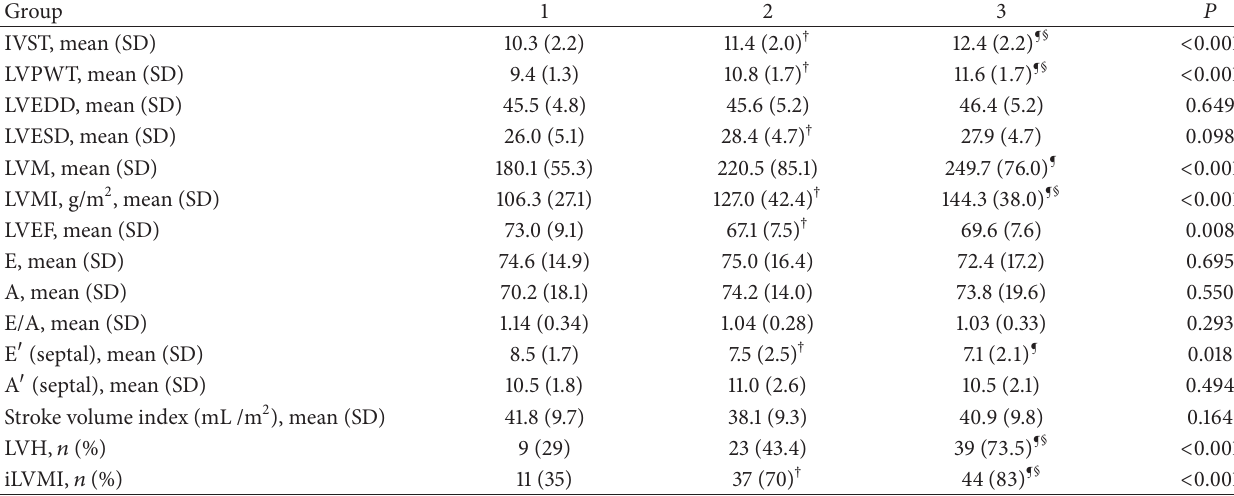
Table 2: Echocardiographic